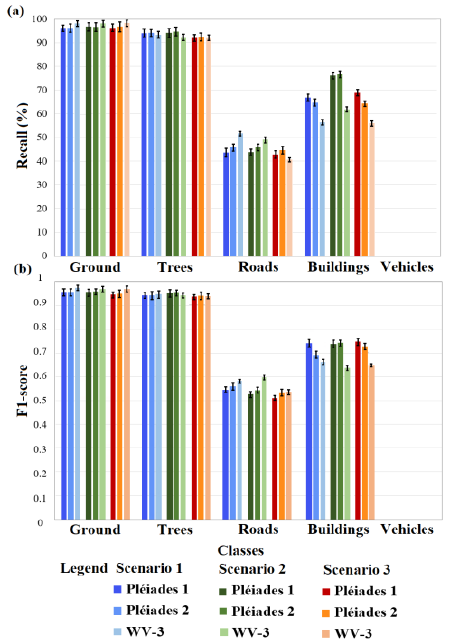
Figure 6. Comparison of average classification metrics with standard deviations (below 3%) for each class in all three scenarios: (a) recall and (b)